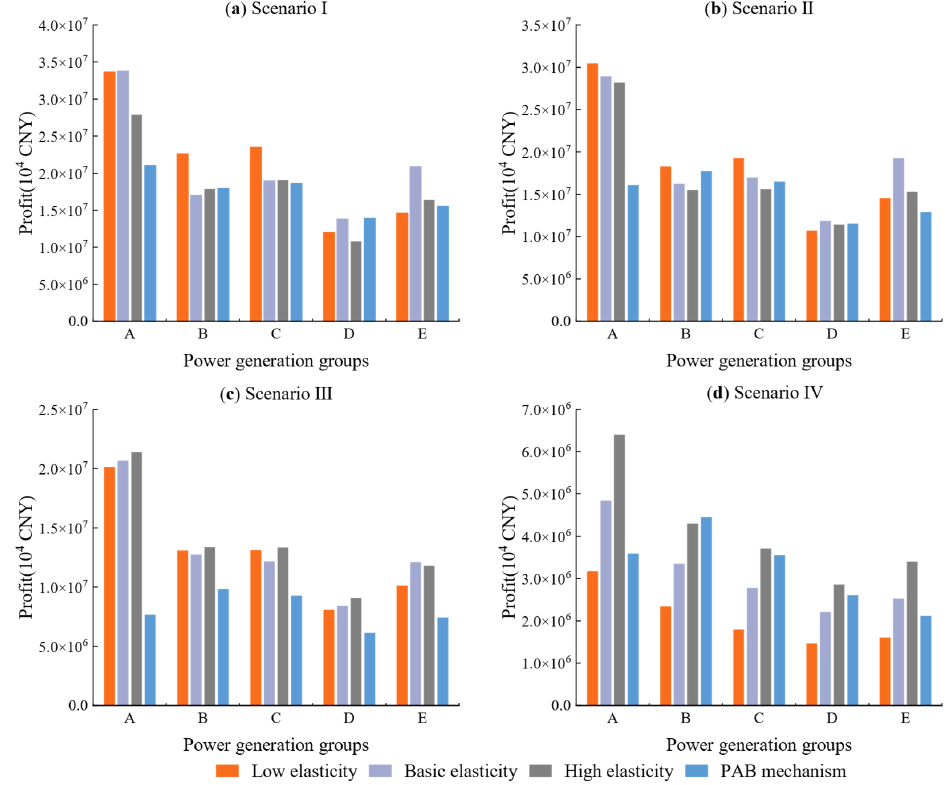
Figure 8. Total pro fi t of each group during the planning period under the supply and demand ad- Figure 8. Total profit of each group during the planning period under the supply and demand justment mechanism and PAB mechanism. adjustment mechanism and PAB